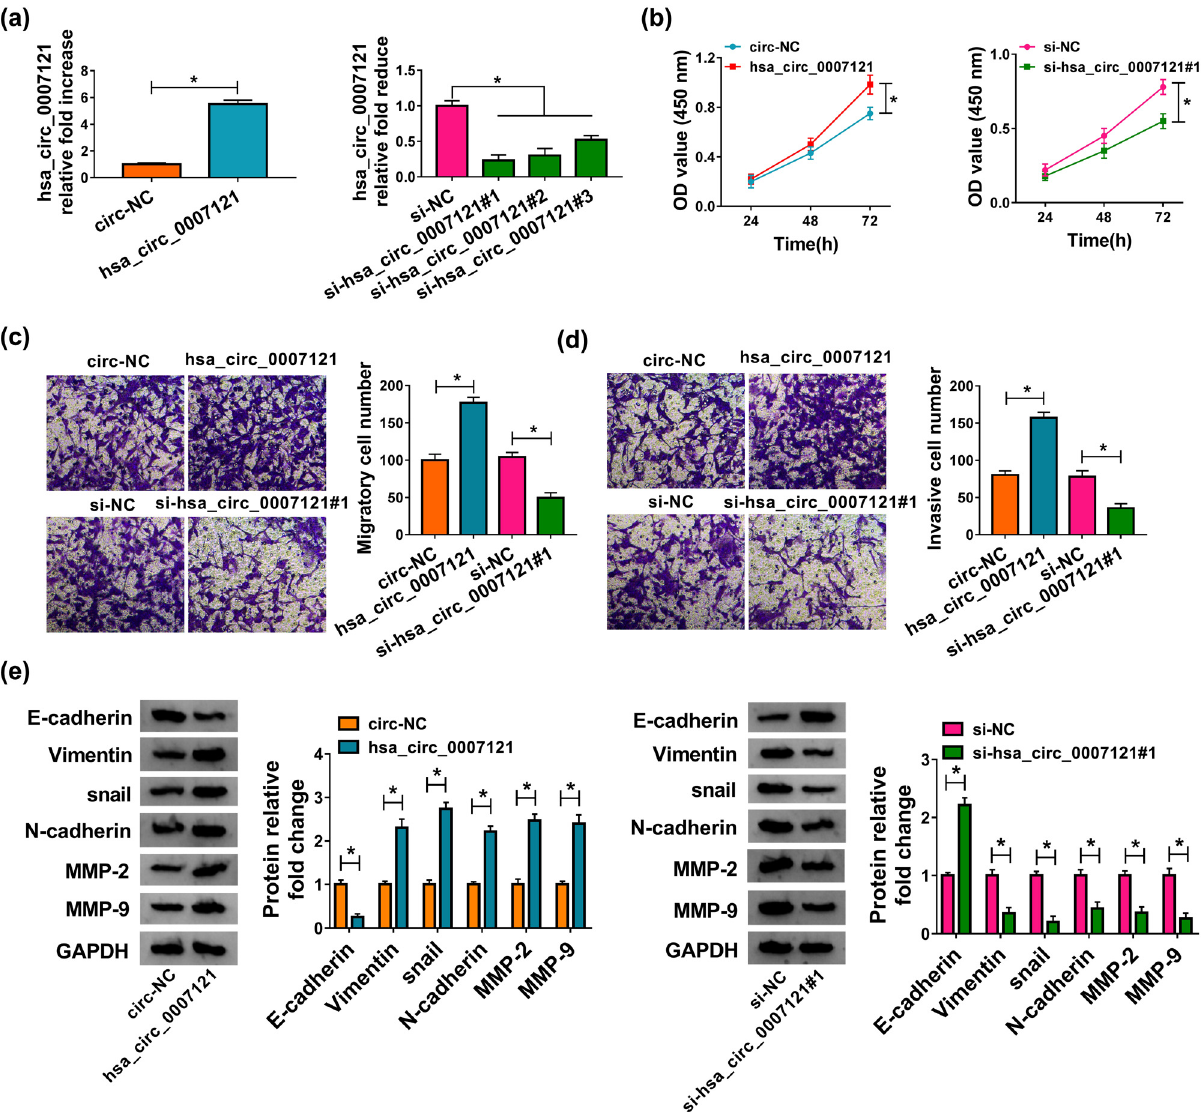
Figure 2: Hsa_circ_0007121 was involved in the regulation of PE. ( a ) The overexpression e ffi ciency of hsa_circ_0007121 and the knockdown e ffi ciency of si - hsa_circ_0007121 ( si - hsa_circ_0007121#1, si - hsa_circ_0007121#2, and si - hsa_circ_0007121#3 ) were evaluated by qRT - PCR. ( b ) The proliferation of HTR - 8/SVneo cells transfected with circ - NC, hsa_circ_0007121, si - NC, or si - hsa_circ_0007121#1 was checked by the CCK8 assay. ( c and d ) Cell migration and invasion were checked by the transwell assay. ( e ) The protein levels of EMT - related proteins ( E - cadherin, Vimentin, snail, N - cadherin, MMP - 2, and MMP - 9 ) in transfected HTR - 8/SVneo cells were measured by western blot assay. * P <